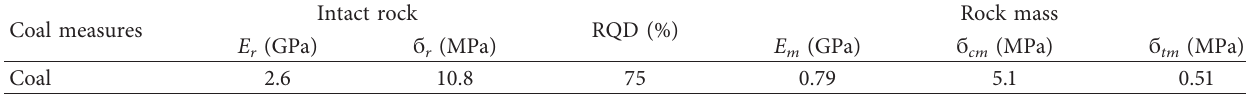
Table 1: Intact rock properties and scaled rock mass properties of coal from the Wangzhuang Coal Mine.